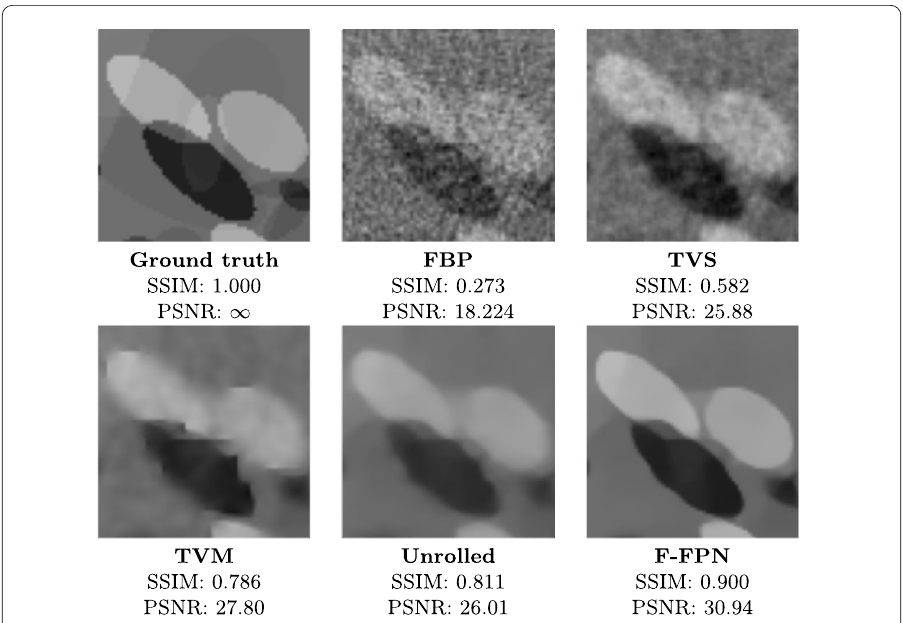
Figure 3 Zoomed-in ellipse reconstruction with test data of Figure 2 for each method: FBP, TVS, TVM, unrolling, and the proposed F-FPN.